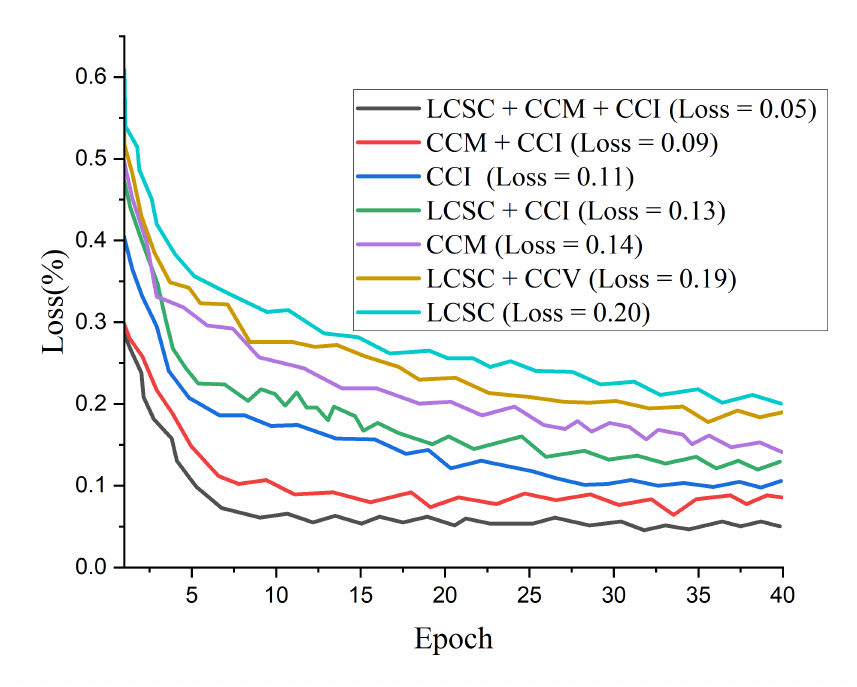
Figure 11. Loss curves for the proposed multi-channel in comparison with the single-channels and